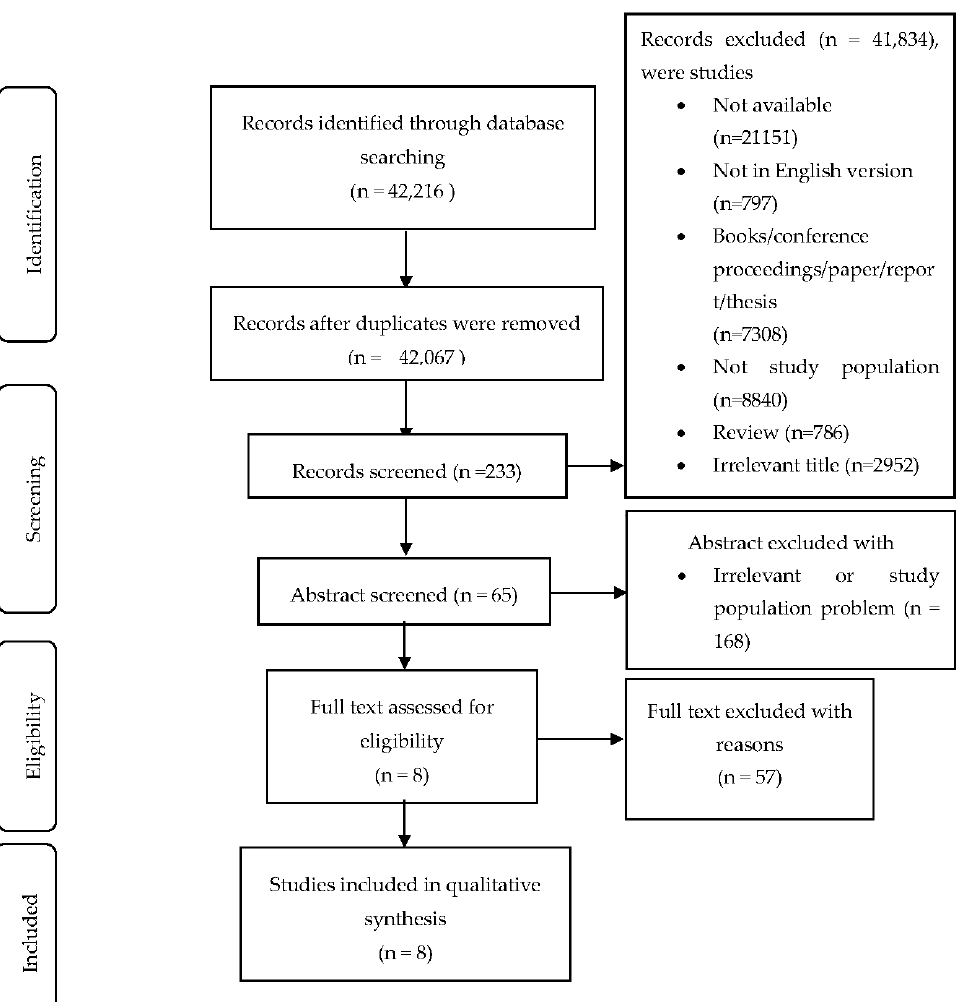
Figure 1. Preferred Reporting Item for Systematic Review and Meta-analysis (PRISMA) 2009, four phase flow diagram of literature search [19].